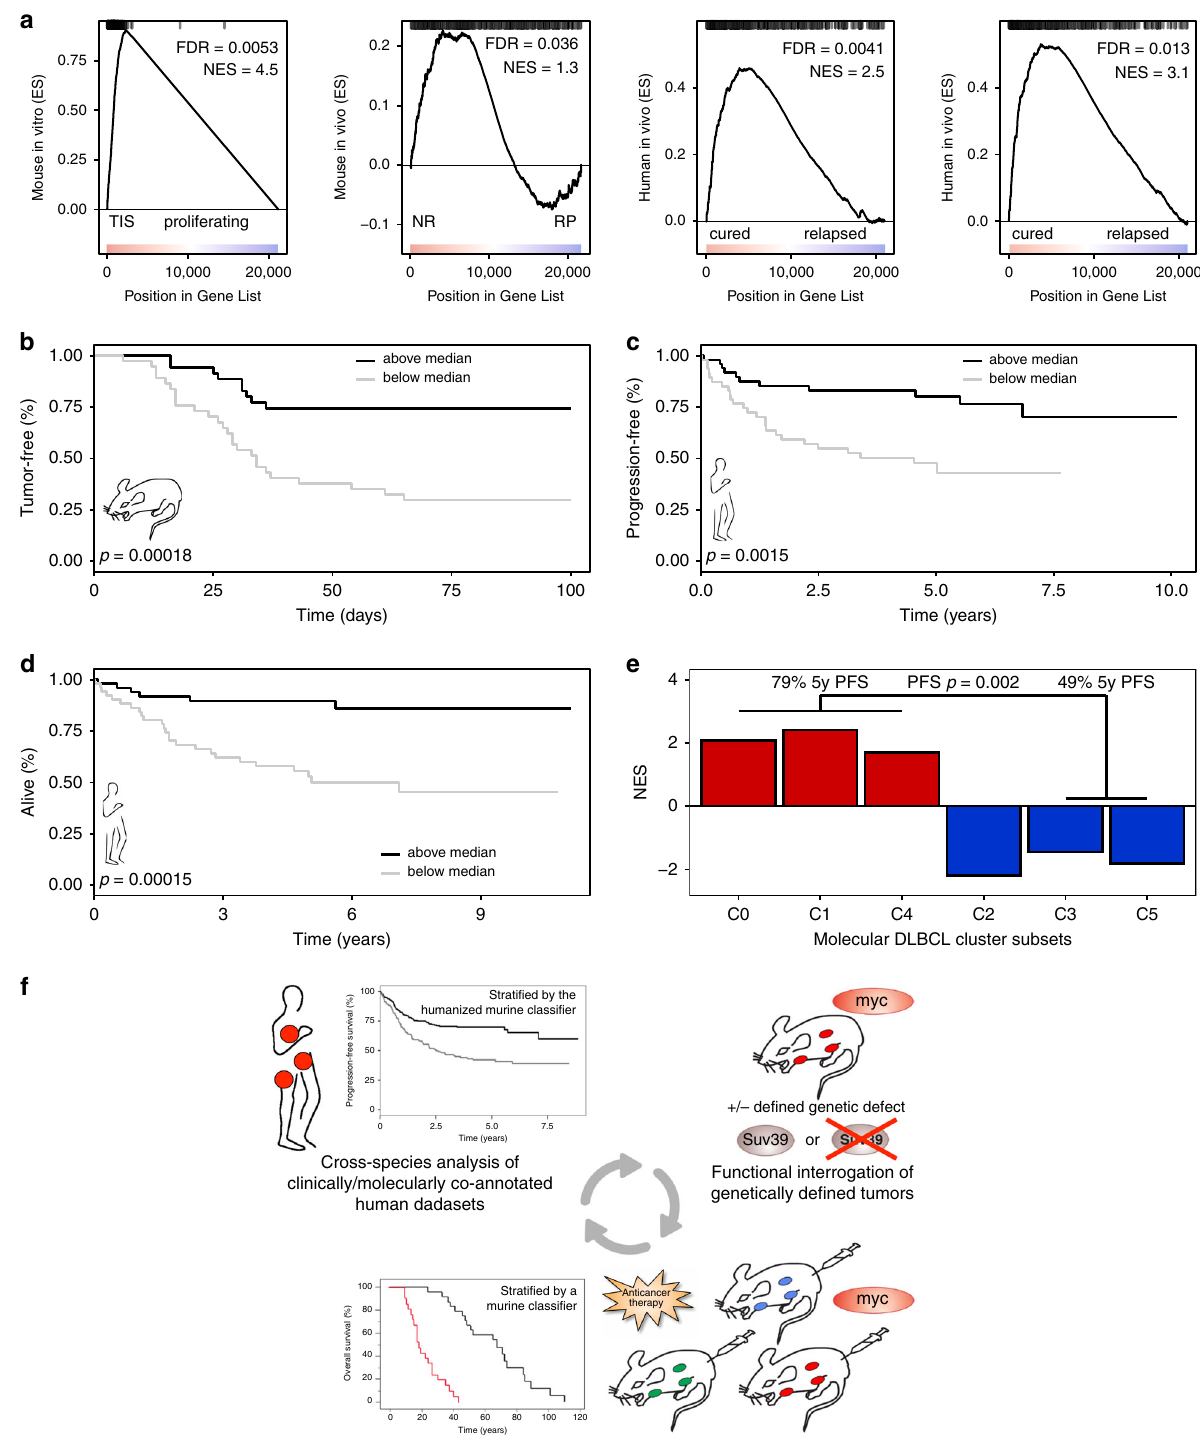
(Fig. 6a, fi rst panel), and, likewise, strongly up in treatment-naïve gene list to the enrichment score [ES] pro fi le peak position), NR Eµ- myc lymphomas in vivo (Fig. 6a, second panel), as well as consisting of 22, notably largely proliferation-independent and in newly diagnosed DLBCL samples of two independent cohorts partly cell – cell/host immune interaction-relevant genes of patients who achieved lasting remissions, when being com- (Table S1), which might serve as a biomarker that anticipates pared to RP mouse or human relapsed/refractory lymphomas, treatment outcome (Fig. 6a). Accordingly, strati fi cation of SENS respectively (Fig. 6a, right panels). Based on these GSEA analyses, Eµ- myc lymphoma based on the average expression of this core we de fi ned a “ core SUVARness ” signature, commonly present in SUVARness signature predicted tumor-free survival, whereby these GSEA ’ s leading edges (i.e., the region from the top of the mice bearing lymphomas with high-level expression experienced NATURE COMMUNICATIONS| (2020) 11:3651